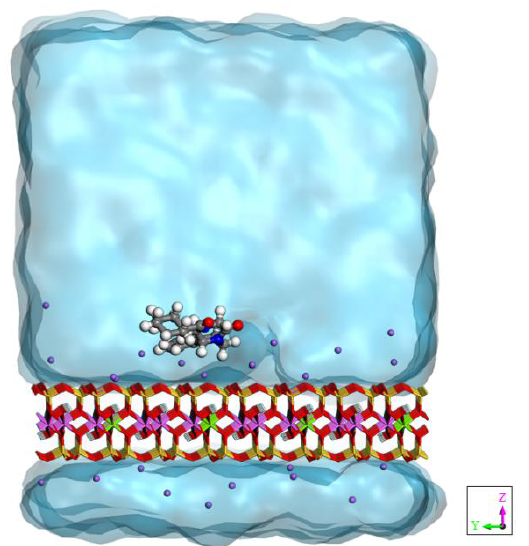
Figure 1. Model of praziquantel adsorbed on the montmorillonite surface in aqueous solution.